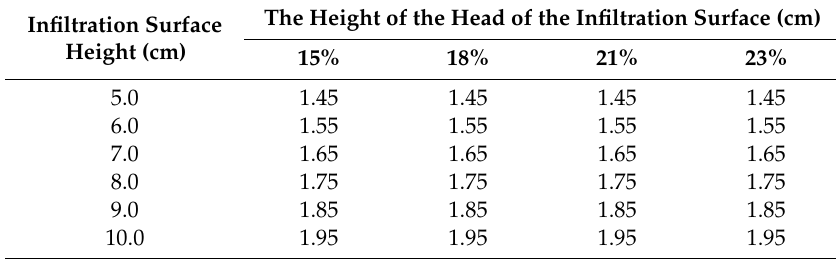
Table 3. Three-dimensional finite element calculation results of di ff erent infiltration surface head heights corresponding to outflow surface head